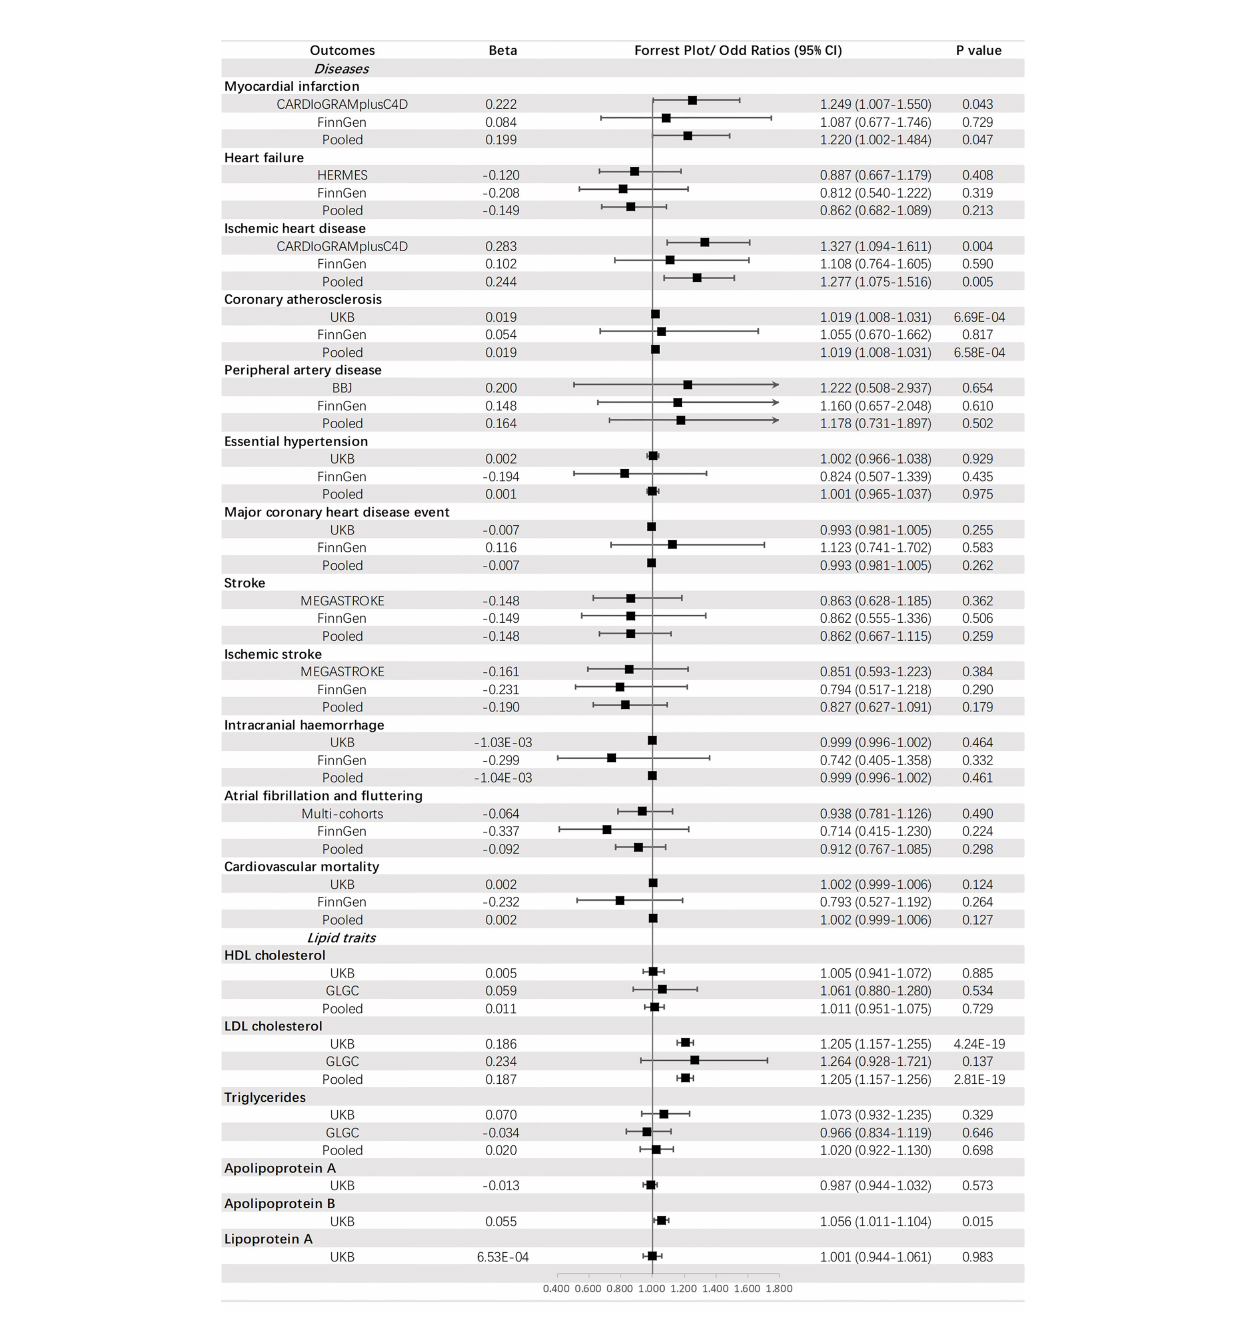
FIGURE 6 | The association between HbA 1c (mmol/mol) and